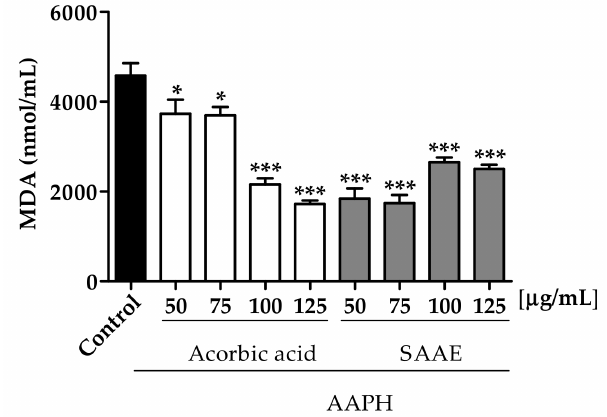
Figure 5. Malondialdehyde (MDA) concentration after adding the oxidizing agent AAPH to erythrocytes incubated for 240 min with different concentrations (50–125 µ g/mL) of ascorbic acid and the SAAE. Data are expressed as the mean ± SEM ( n = 3) in duplicate. * p < 0.05 and *** p < 0.0001 compared with the control group AAPH.